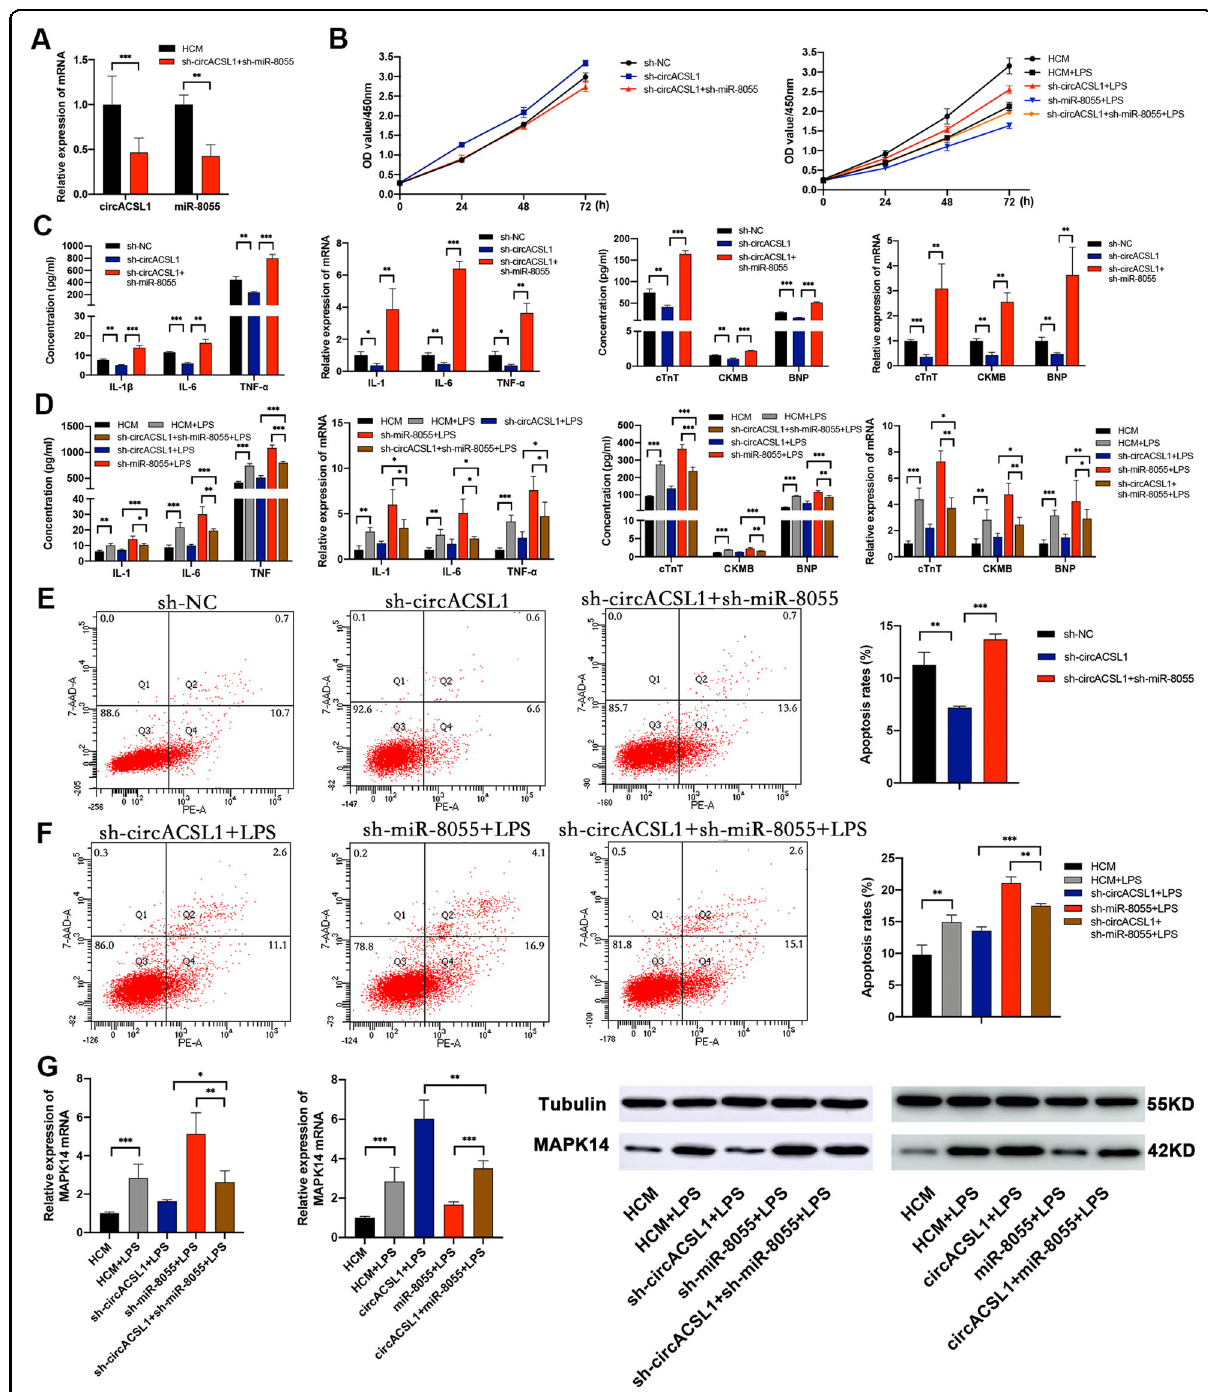
Fig. 6 Kockdown of circACSL1-mediated attenuation in myocardial in fl ammation and myocardial injury can be rescued by sh-miR-8055. A – G HCM cells were co-transfected with sh-circACSL1 and sh-miR-8055, which were compared with sh-circACSL1 transfection alone or sh-miR-8055 transfection alone. A The knockdown ef fi ciencies of circACSL1 and miR-8055 in HCM cells were detected by qRT-PCR. B Sh-miR-8055 abolished the suppressive effects of sh-circACSL1 on HCM cell proliferation. C , D Sh-circACSL1-induced downregulation of IL-1 β , IL-6, TNF- α , cTnT, CKMB, and BNP were rescued by co-transfection with sh-circACSL1 and sh-miR-8055. E , F Sh-circACSL1-induced decrease of cell apoptosis was reversed by co- transfection with sh-circACSL1 and sh-miR-8055. G qRT-PCR and WB results showed the mRNA and protein levels of MAPK14. Data are presented as mean ±SD ( n = 3 biologically independent samples). * p < 0.05; ** p < 0.01; *** p < 0.001 (Student ’ s t